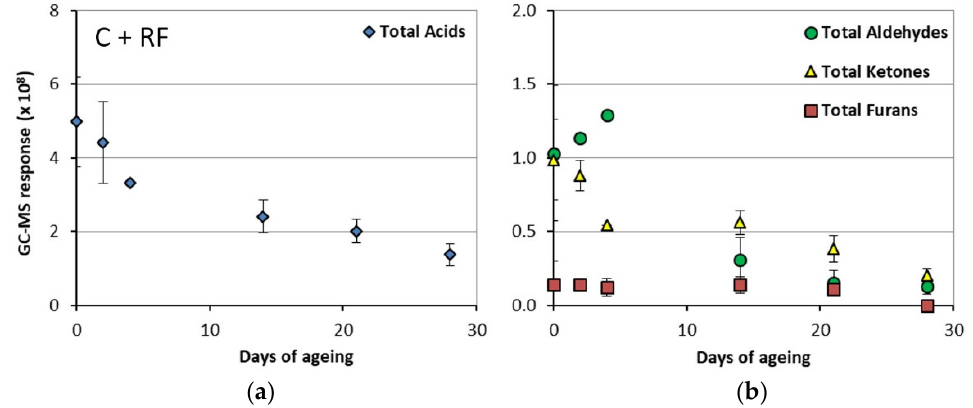
Figure 11. The evolution of the basic chemical groups of VOCs’ emission by cotton mock-ups im-